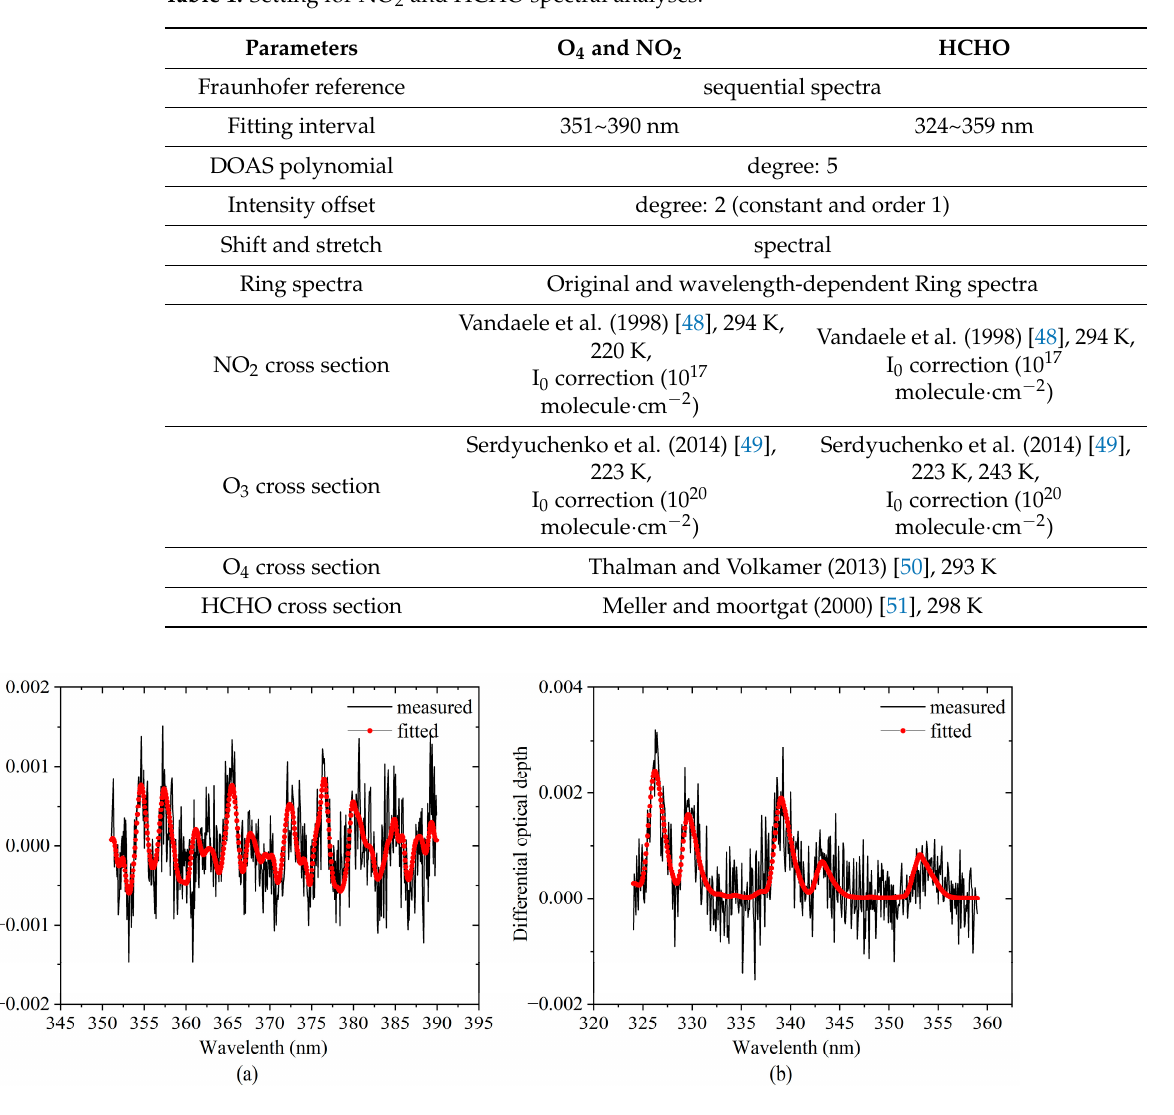
Figure 2. Examples of spectral fitting for ( a ) NO 2 and ( b ) HCHO. Black and red curves are the measured and fitted differential optical depths, respectively. The NO 2 and HCHO dSCDs are 1.10 × 10 16 molecule·cm − 2 and 2.30 × 10 16 molecule·cm − 2 , respectively. The RMS between measured and fitted spectra are 7.63 × 10 − 4 for NO 2 and 8.98 × 10 − 4 for HCHO, respectively. Table 1. Setting for NO 2 and HCHO spectral analyses.